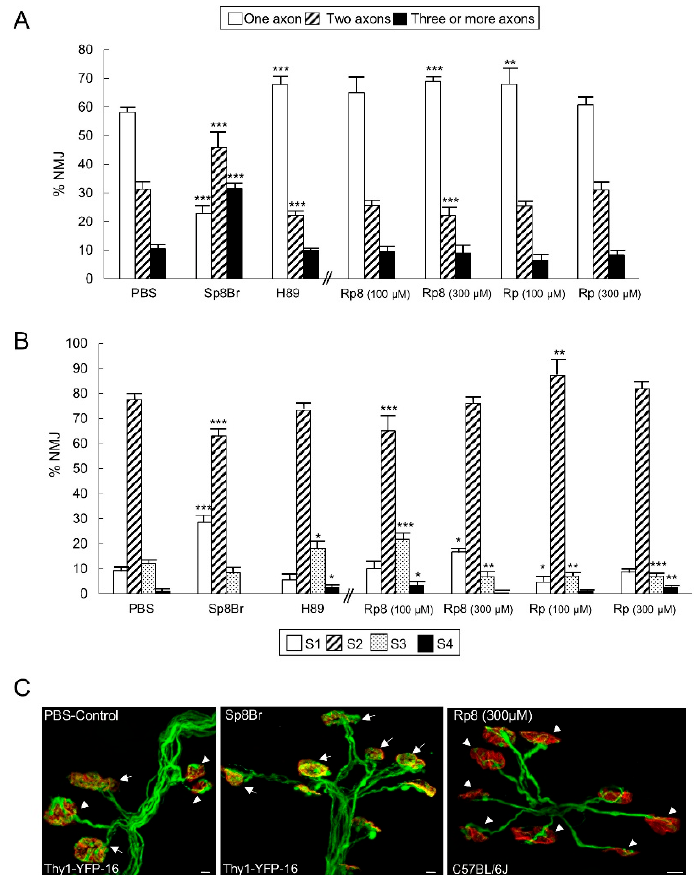
Figure 2. PKA activity modulation in axonal loss and postsynaptic receptor cluster maturation. The histogram in ( A ) shows the percentage of singly-, doubly-, and triply- (or more) innervated NMJs in the untreated control mice (only PBS) and after four applications (one application every day between P5 and P8, observation at P9) of one of the following substances: the PKA inhibitor H-89, the PKA stimulator Sp8Br, and the selective antagonists of the PKA regulatory subunits RI (Rp8) and RII (Rp) at two concentrations (100–300 µ M). The data show that PKA inhibition accelerates axonal elimination while PKA stimulation delays axonal loss. The results on the selective antagonists of the RI and RII regulatory subunits suggest that some of the di ff erences in the dose-dependence between the blocking peptides may be attributed to di ff erences in a ffi nity for the respective R subunits. The histogram in ( B ) shows that PKA inhibition moderately accelerates postsynaptic maturation while stimulation delays it. Thus, in normal conditions, PKA prevents developmental postsynaptic cluster di ff erentiation. The results on the selective antagonists of the RI and RII subunits unexpectedly show that the RI inhibitor at 300 µ M delays postsynaptic maturation, which suggests a downregulation e ff ect at the highest dose of Rp8. Data were presented as percentages of NMJ ± SD (for each treatment and PBS control: n pups = 6–9; n = 11–18 Levator auris longus (LAL) muscles; n NMJ: PBS: 2538; H89: 1265; Sp8Br: 1324; Rp8 100 µ M: 1140; Rp8 300 µ M: 1287; Rp 100 µ M: 1943; Rp 300 µ M: 2102). Fisher’s test: * p < 0.05, ** p < 0.01, *** p < 0.005. The confocal images in ( C ) show representative areas of the LAL terminal innervation (control PBS, left; arrow heads in monoinnervated junctions and arrows in multiinnervated NMJ) in which PKA stimulation with Sp8Br (center) delays axon loss because many multiinnervated NMJs (arrows) persist. On the contrary, the antagonist of the PKA RI subunit (Rp8 at 300 µ M, right) increases the number of monoinnervated junctions (arrow